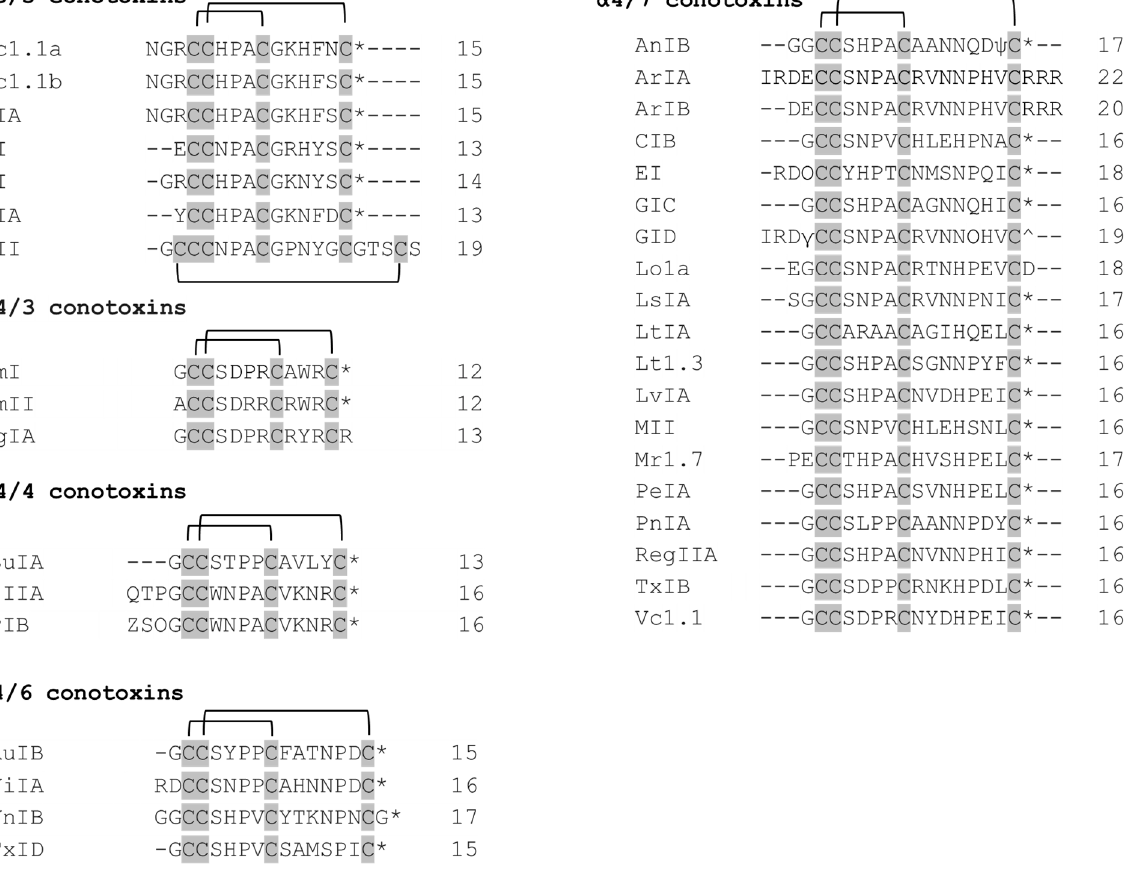
Figure 2. Sequence alignment of the α -conotoxins listed in a Table 1. The α -conotoxins with 3/5, 4/4, 4/6, and 4/7 spacing. The cysteines residues are shaded in gray and intrachain disulfide bonds are shown. The number of residues in each toxin is given to the right. * C—terminal carboxamide, ^ C—terminal carboxylate, ψ —sulfated tyrosine, O —hydroxyproline, Z —pyroglutamate.